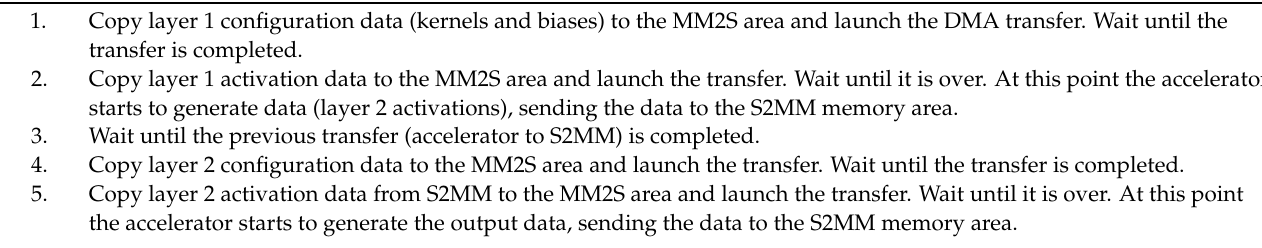
Algorithm 1: Transference trace for the execution of a 2-layer NN.